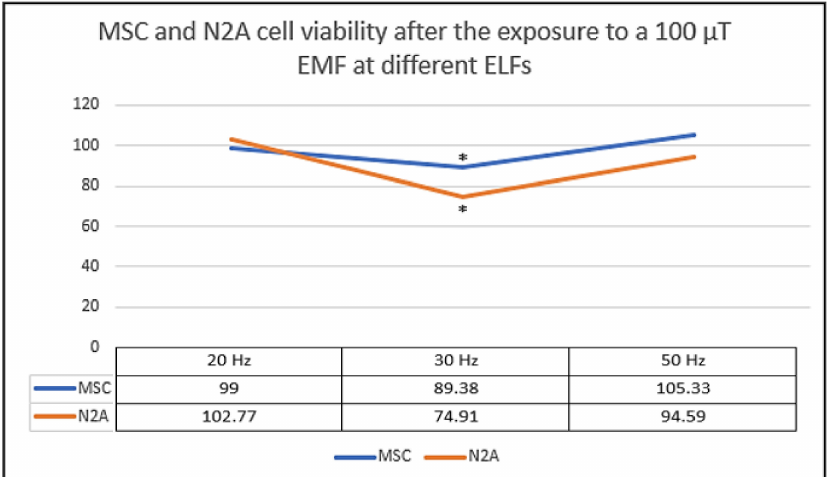
Figure 5. Mesenchymal stem cells (MSC) and N2A cell viability after 24 h exposure to a non-ionizing field of 100 µ T. The results from three independent experiments which each frequency and cell type are plotted on graph. The data are expressed as the means ± standard error, and * indicates a significant cell viability difference from MSC and N2A cells to their corresponding control groups ( p < 0.05)